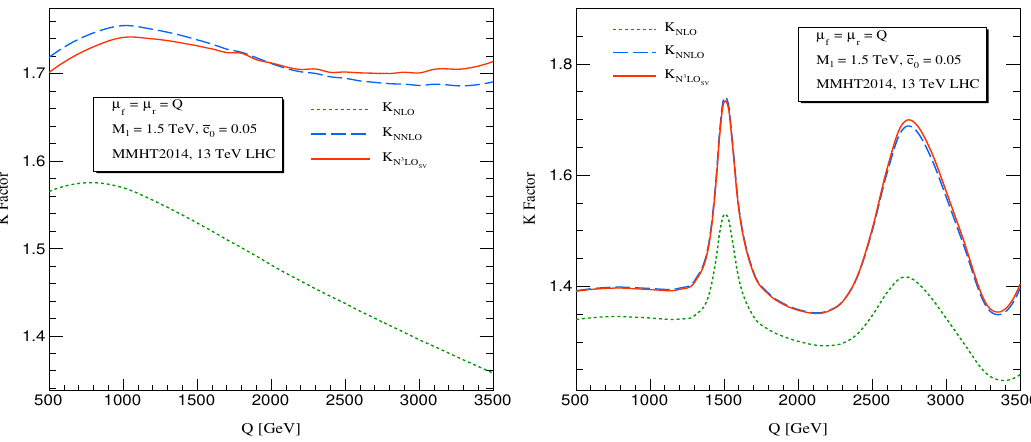
Figure 7 . K-factors are presented up to N 3 LO sv for the RS model (left) and for the signal (right). 7-point scale uncertainty is seen to increase at the lower invariant mass region whereas as we reach higher invariant mass region this becomes better. To further constraint the scale uncertainty the N 3 LO PDFs are essential at this order. Also the missing sub-leading pieces are important in particular in the low- Q region (see e.g. [40, 121]). The (cid:22) however is seen to improve in the whole invariant mass region. Keeping (cid:22) observe an uncertainty of (cid:6) 0 : 9% around the resonance M range (1 = 2 ; 2) M 1